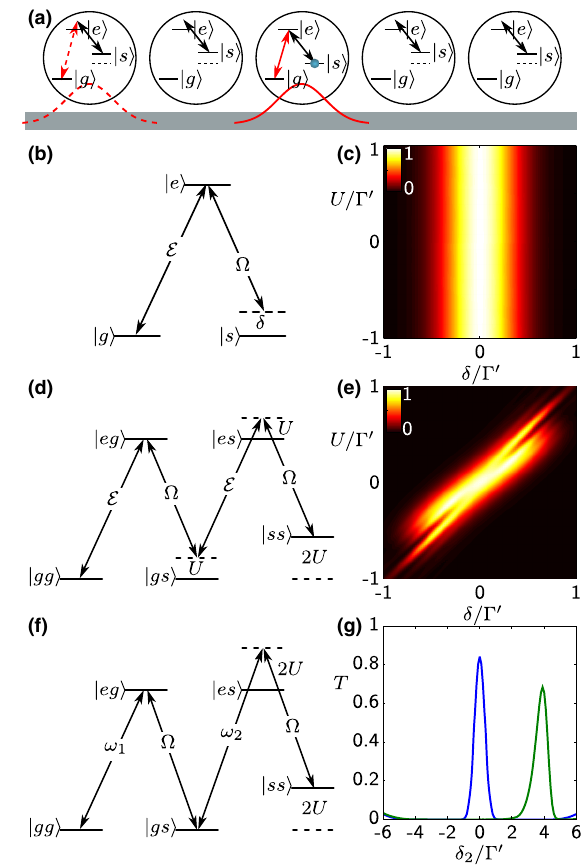
FIG. 2. (a) The excitation of the central atom to j s i by a probe pulse (red line) traveling along the waveguide (grey), shifts the level j s i of the surrounding atoms and a new pulse (dashed red line) encounters a shifted EIT transparency window. (b – e) EIT with P ℏ U σ j σ l uniform interactions H leads to number- ss ss ¼ ss j ≠ l correlated transparency windows. (b) For a single photon, EIT occurs at the normal two-photon resonance δ ¼ 0 , independently of U , as shown in (c) by the simulated output intensity E I 1 ¼ h E † o E = h E † , which for weak input intensity corresponds o i i i i to the transmittance of single photons. (d) For two photons, EIT occurs for δ ¼ U , in which case transfer to the j ss i two-excitation state is resonant, as shown in (e) by the equal-time coincidence rate 2 , which has a maximum for E E = h E † at output I 2 ¼ h E † o E † o E o o i i i i δ ∼ U . In (c) and (e), the system has optical depth D ¼ 400 and is 2 ¼ 10 − 4 Γ 0 and Δ ¼ 0 . (Note that continuously pumped with j E i j δ ¼ U can be achieved by adjusting the probe or control field frequencies;here, we adjust the control,which in this case results in higher two-photon coincidence counts for j U j > 0 . 5 .) (f) Two- photon transmission is also achieved by inputting two pulses with different frequencies ω 1 and ω 2 , where the first pulse is inside the medium when the second arrives [as in (a)]. For δ ∼ 0 , a single photon from the first pulse may propagate in the 1